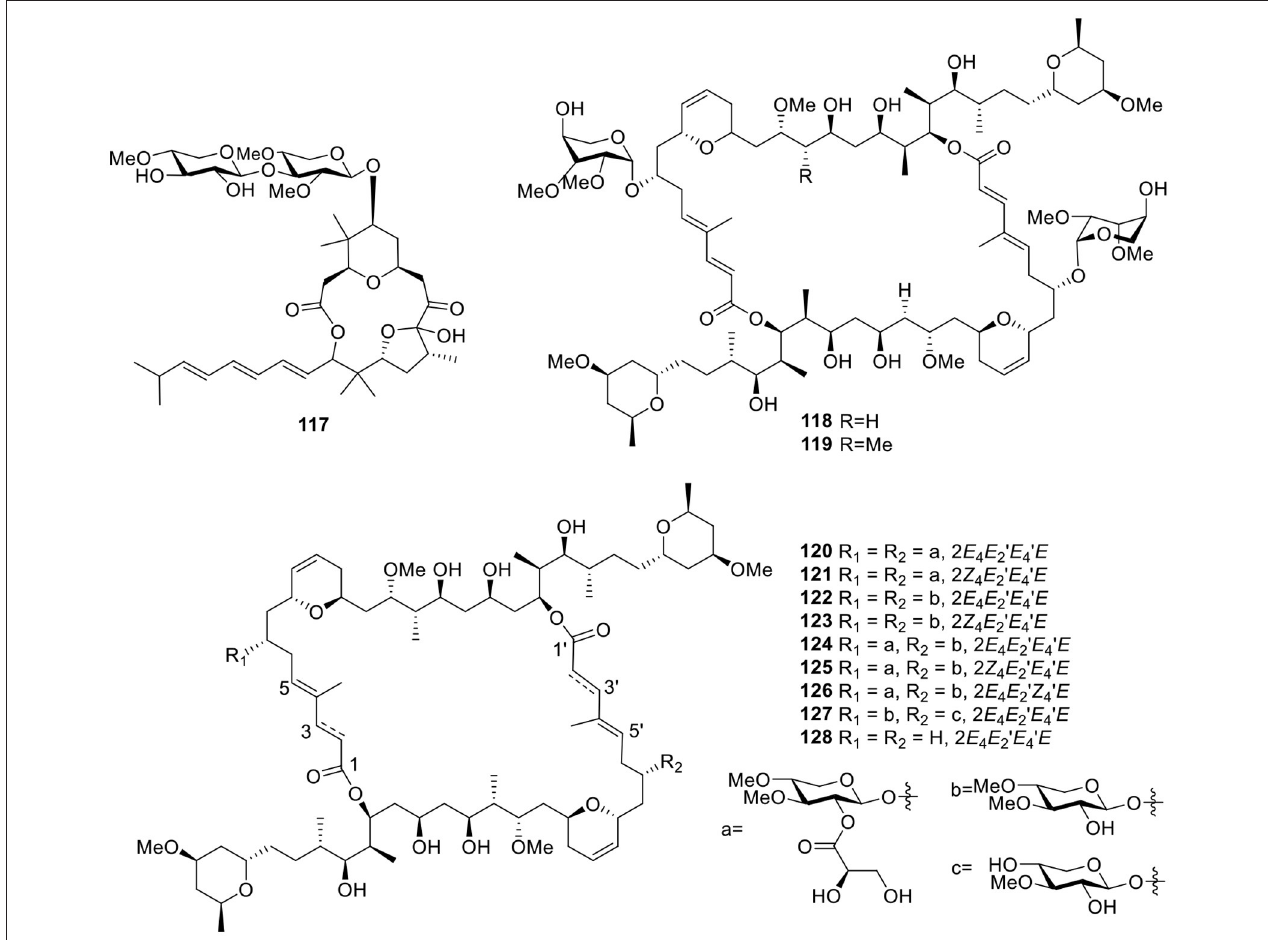
FIGURE 9 | Chemical structures of compounds 117–128 derived from marine-sourced cyanobacteria.